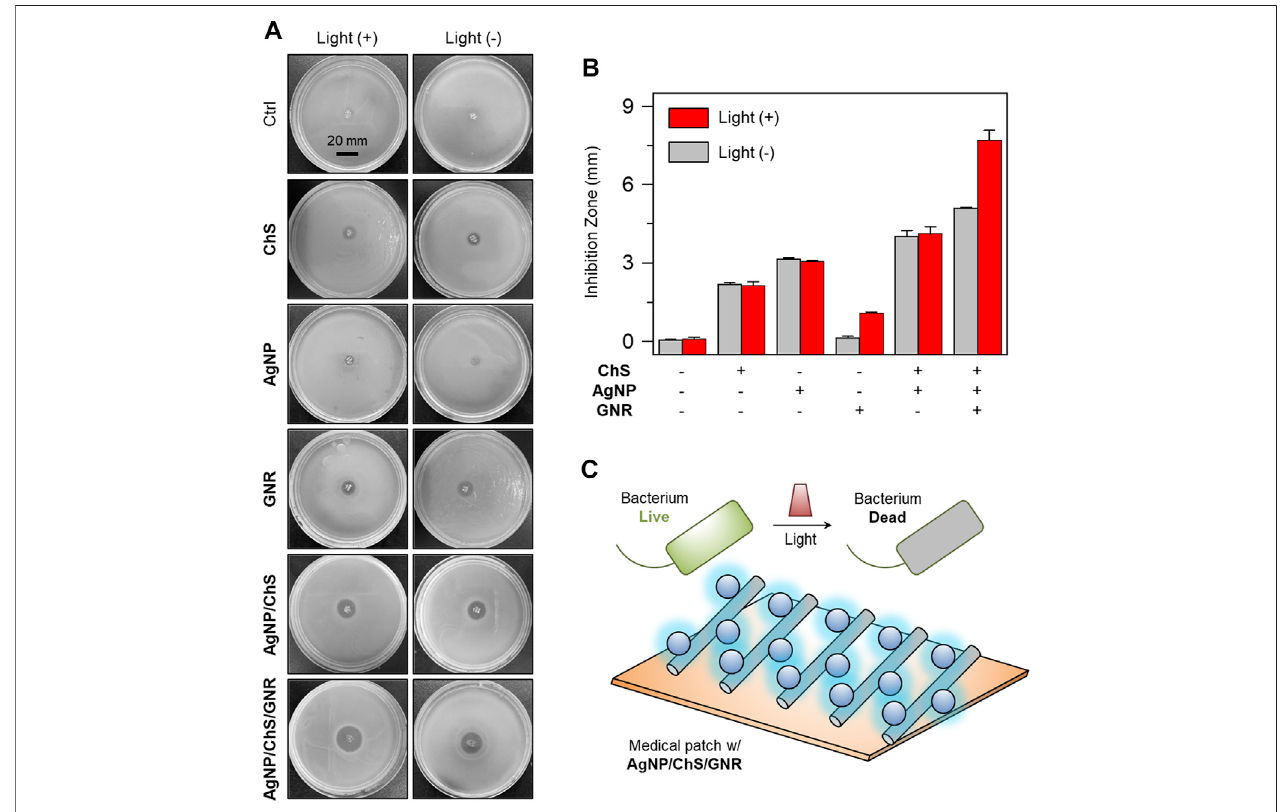
FIGURE4 |(A) Photos(taken bya Nikon camera) and (B) diameters ofthe inhibition zone produced on Luria – Bertani (LB) agar plates culturedwith Pseudomonas aeruginosa (ATCC 27853, 106 CFU ml − 1 ) after treatment with ChS (2 mg ml − 1 ), AgNP (10 μ g ml − 1 ), GNR (20 μ g ml − 1 ), ChS/AgNP (2 mg ml − 1 /10 μ g ml − 1 ) and AgNP/ ChS/GNR (10 μ g ml − 1 /2 mg ml − 1 /20 μ g ml − 1 ) with and without light irradiation (808 nm, 1 W cm − 2 ). (C) Schematic illustration of the light-triggered bacterial eradication using AgNP/ChS/GNR on medical